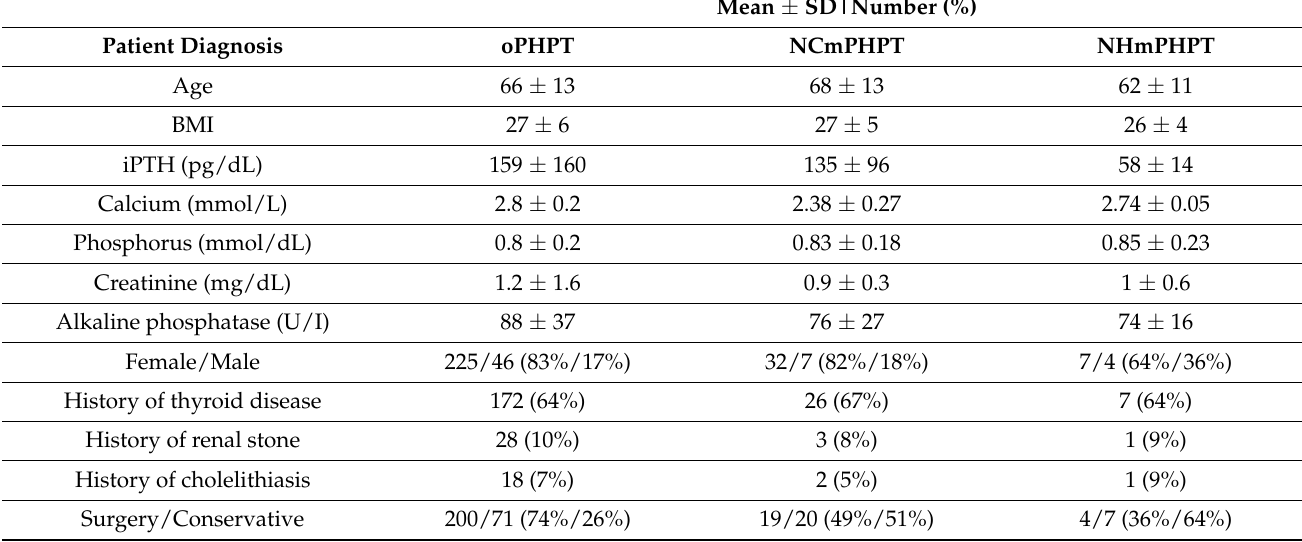
Table 1. Detailed characteristics of the patient’s population ( n = 271).